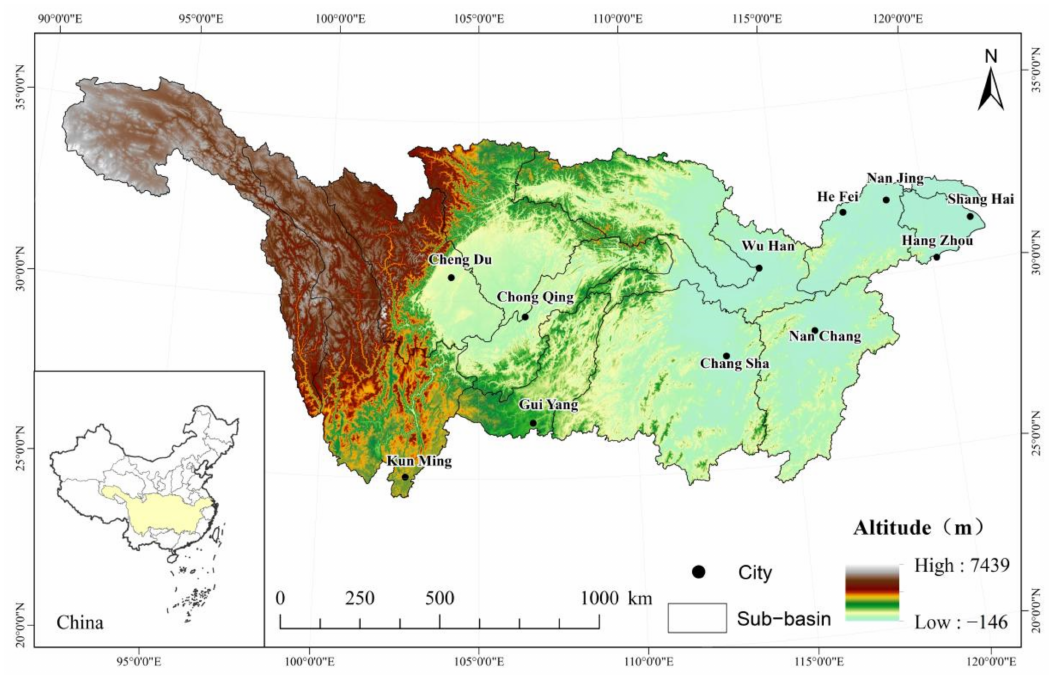
Figure 1. Topographical map of the Yangtze River